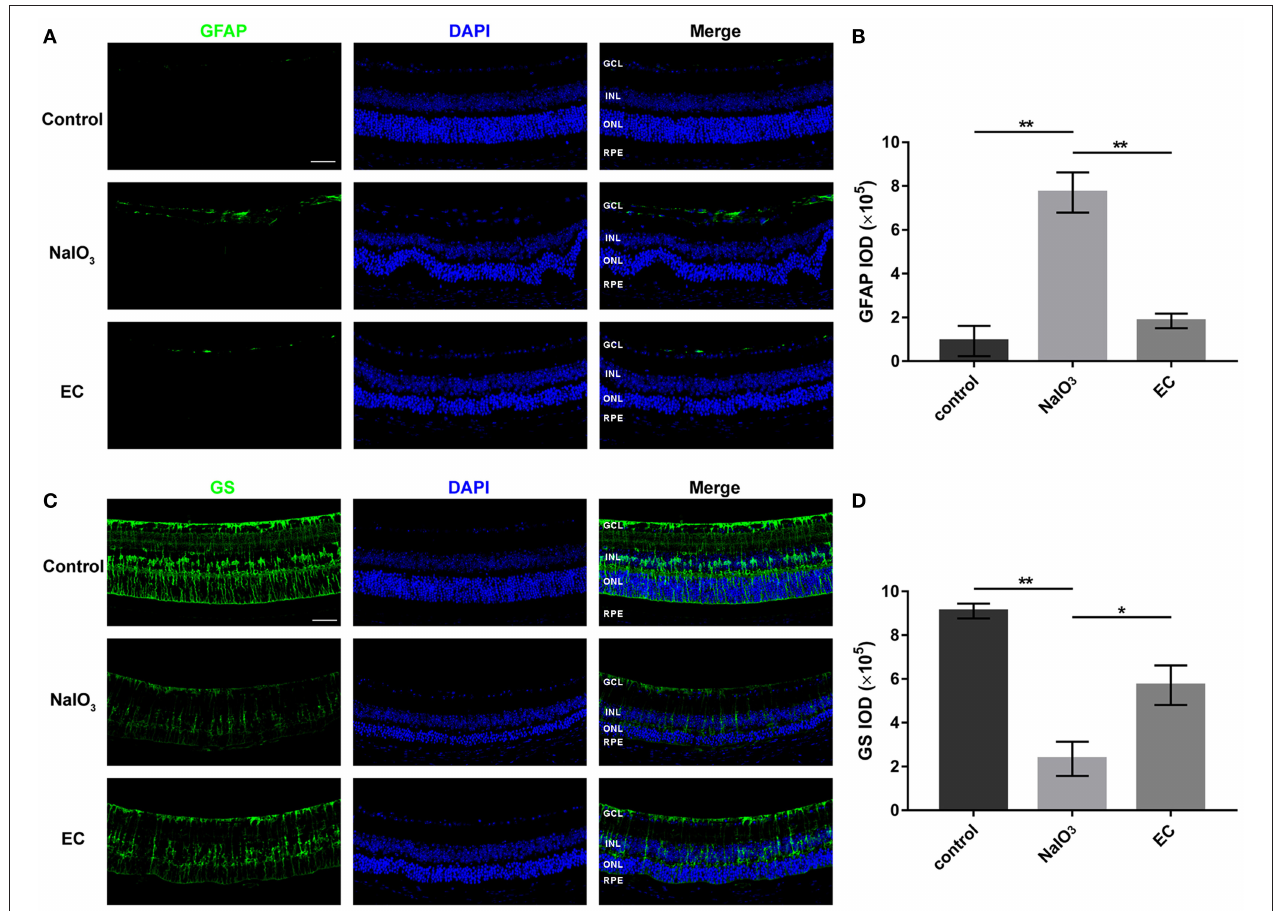
FIGURE 6 | EC reduced astrogliosis and protected Müller cells in NaIO 3 -treated retinas. (A) Immunofluorescence images show GFAP intensity in the three groups. GFAP (green), DAPI (blue). (B) Quantification of GFAP fluorescence intensity. (C) Immunofluorescence images show GS intensity in the three groups. GS (green), DAPI (blue). (D) Quantification of GS fluorescence intensity. GCL, Ganglion cell layer; INL, inner nuclear layer; ONL, outer nuclear layer; RPE, retinal pigment epithelium; IOD, integrated optical density. Values are presented as the mean with SEM; n = 3. * p < 0.05, ** p <